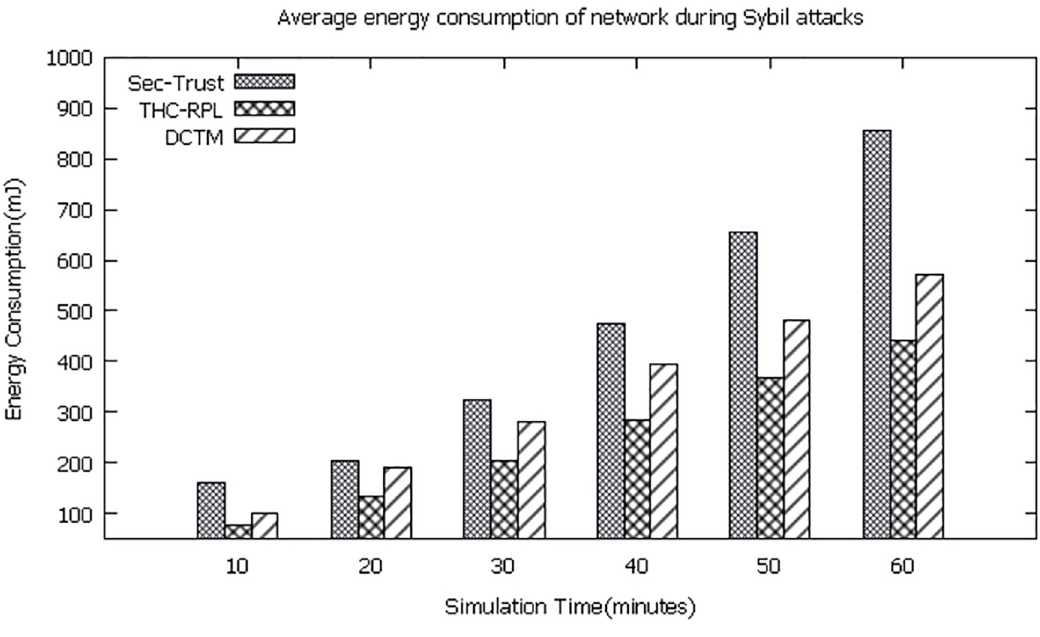
Fig 16. Energy consumption of